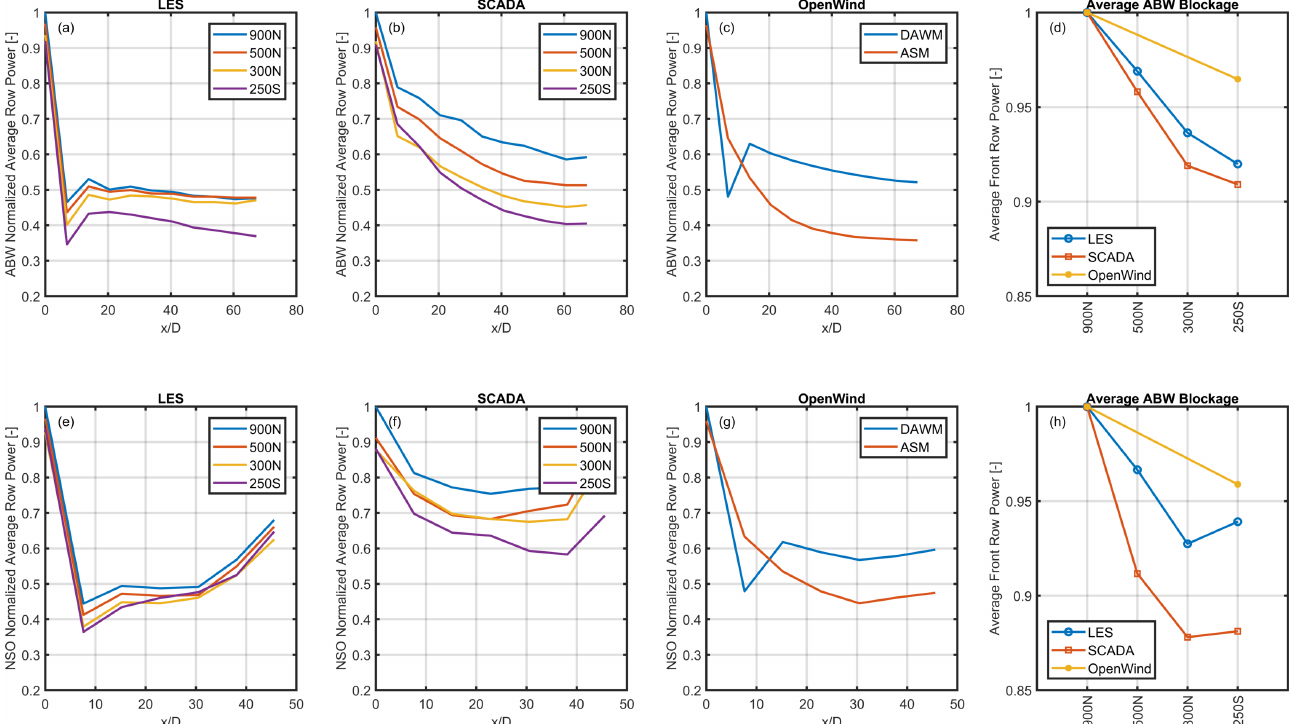
Figure 9. Normalized (by the 900N average front row power) average row power through the ( a – c ) ABW and ( e – g ) NSO wind farms according to the ( a , e ) LES, ( b , f ) SCADA, and ( c , g ) OpenWind results. Here, x / D = 0 represents the front row, while x / D ≈ 70 is the final row of the ABW wind farm. The cases in the legend are defined above in Table 3. The average front (or most-western) row power normalized by the 900N case is shown for the ( d ) ABW and ( h ) NSO wind farms for each of the LES (blue), SCADA (red) and OpenWind (yellow)